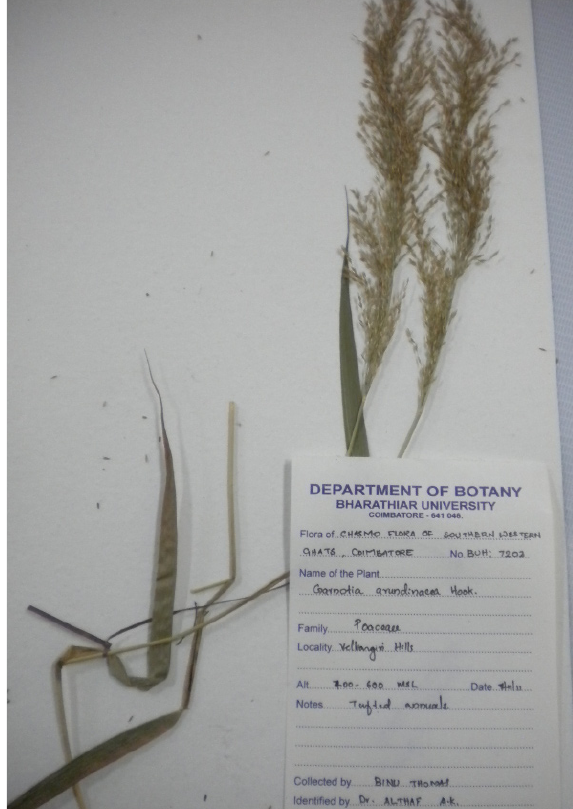
Image 21. Garnotia arundinacea Hook.